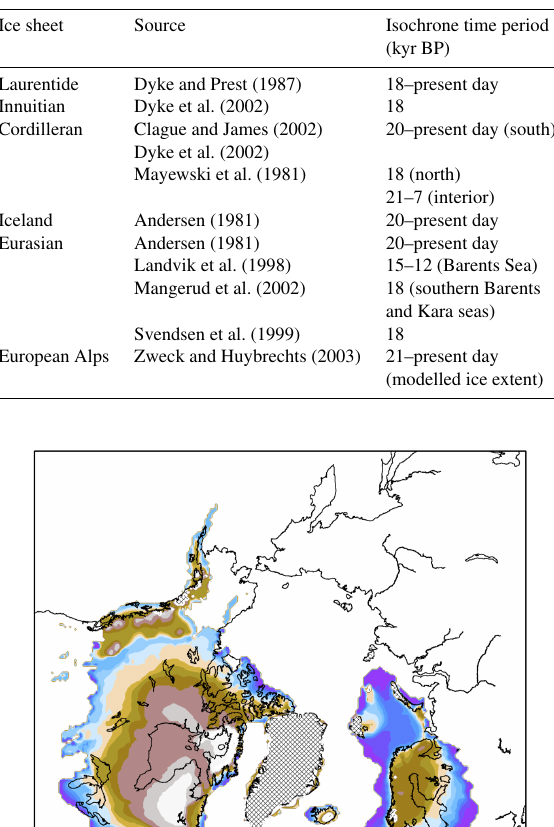
Table A1. Sources of geomorphological data or modelling results used to prescribe changes in Northern Hemisphere ice sheet extent for the retreat during Termination I.